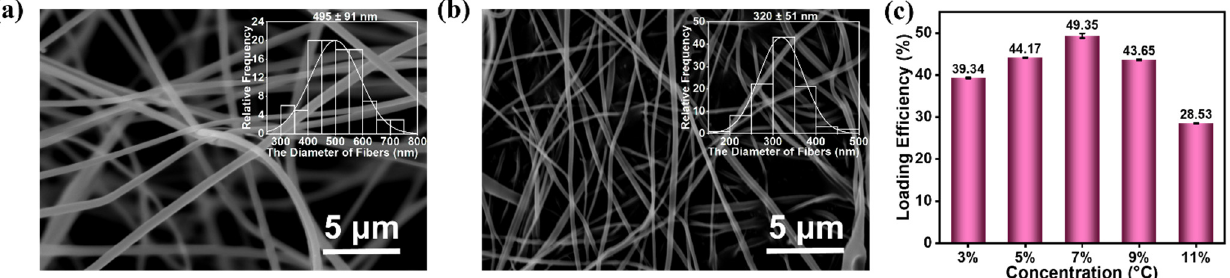
Figure 1. ( a , b ) SEM images of the CA@Anthocyanin UFs with various concentrations of